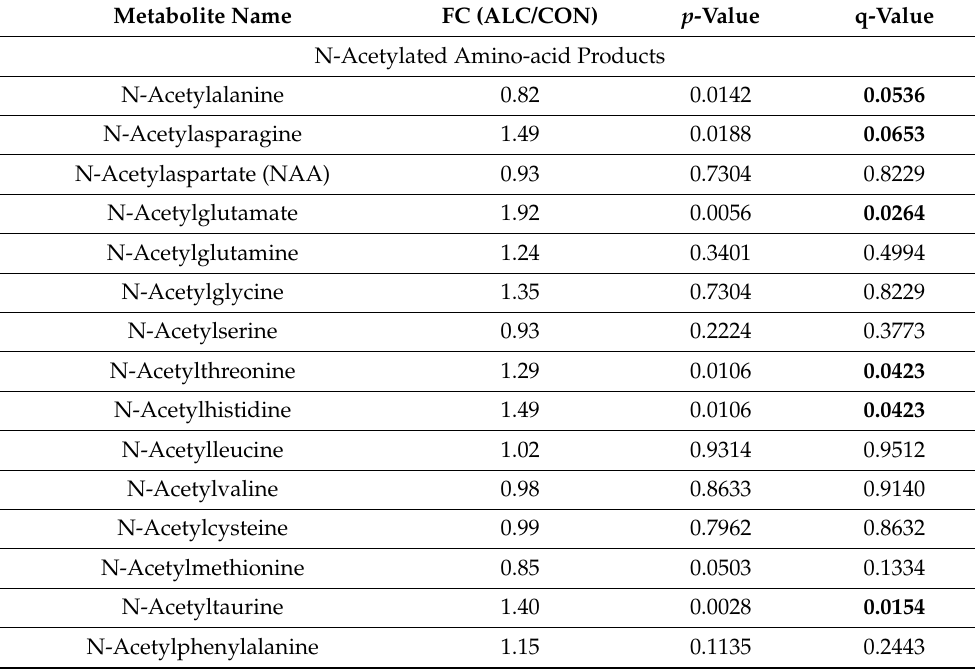
Table 2. List of amino acid catabolite products and fatty acyl carnitines in alcohol-exposed maternal liver with fold change (FC) and q-values. q ≤ 0.10 is